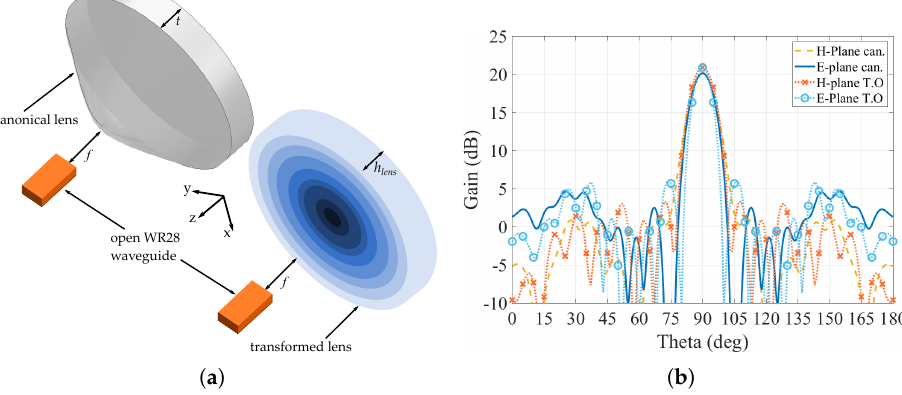
Figure 4. Hyperbolic lenses under test. ( a ) Canonical and transformed lenses with their feeding open waveguide. ( b ) Gain radiation pattern (E-Plane and H-Plane) of the canonical hyperbolic lens (can.) and the hyperbolic transformed flat lens